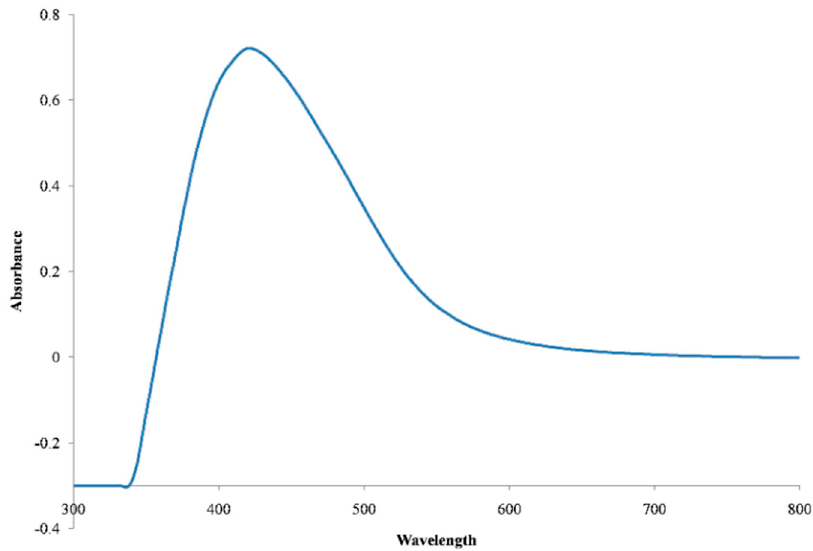
Figure 2. UV-Vis spectra of the synthesized AgNPs.